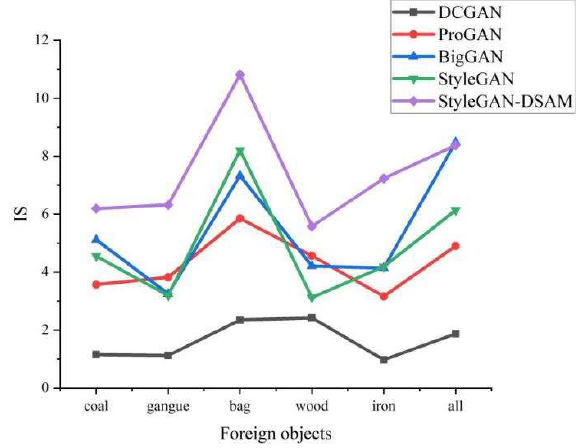
Figure 10. Comparison of IS.